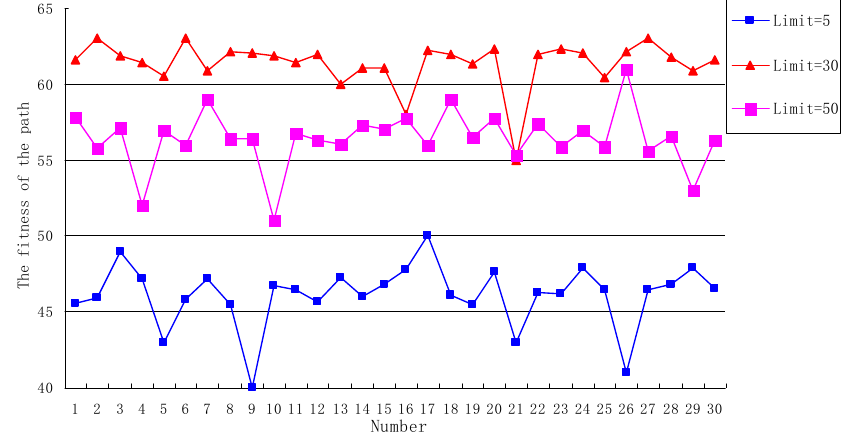
Figure 6. The fitness of the path when the Limit is different.